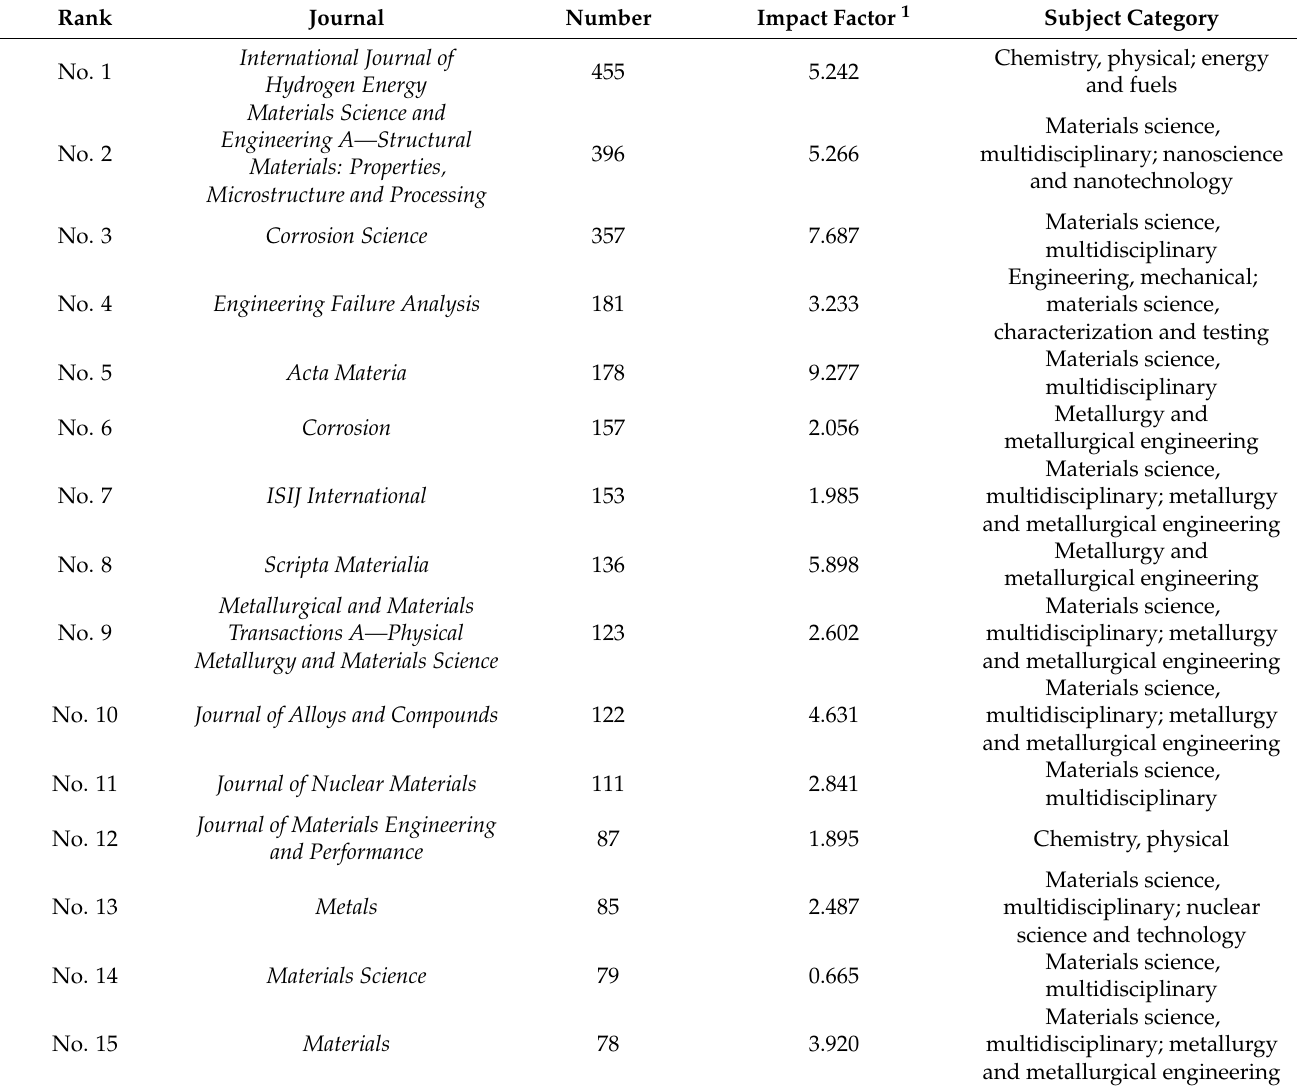
Table 5. Top 15 main sources for publications on hydrogen embrittlement from